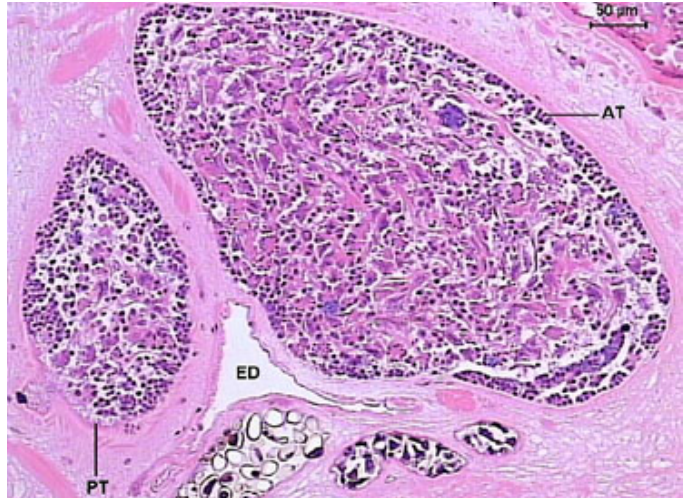
Figure 20. Transversal section of the Sticholecitha serpentis testicles. AT – anterior testicle, PT – posterior testicle, ED – excretory duct. HE.